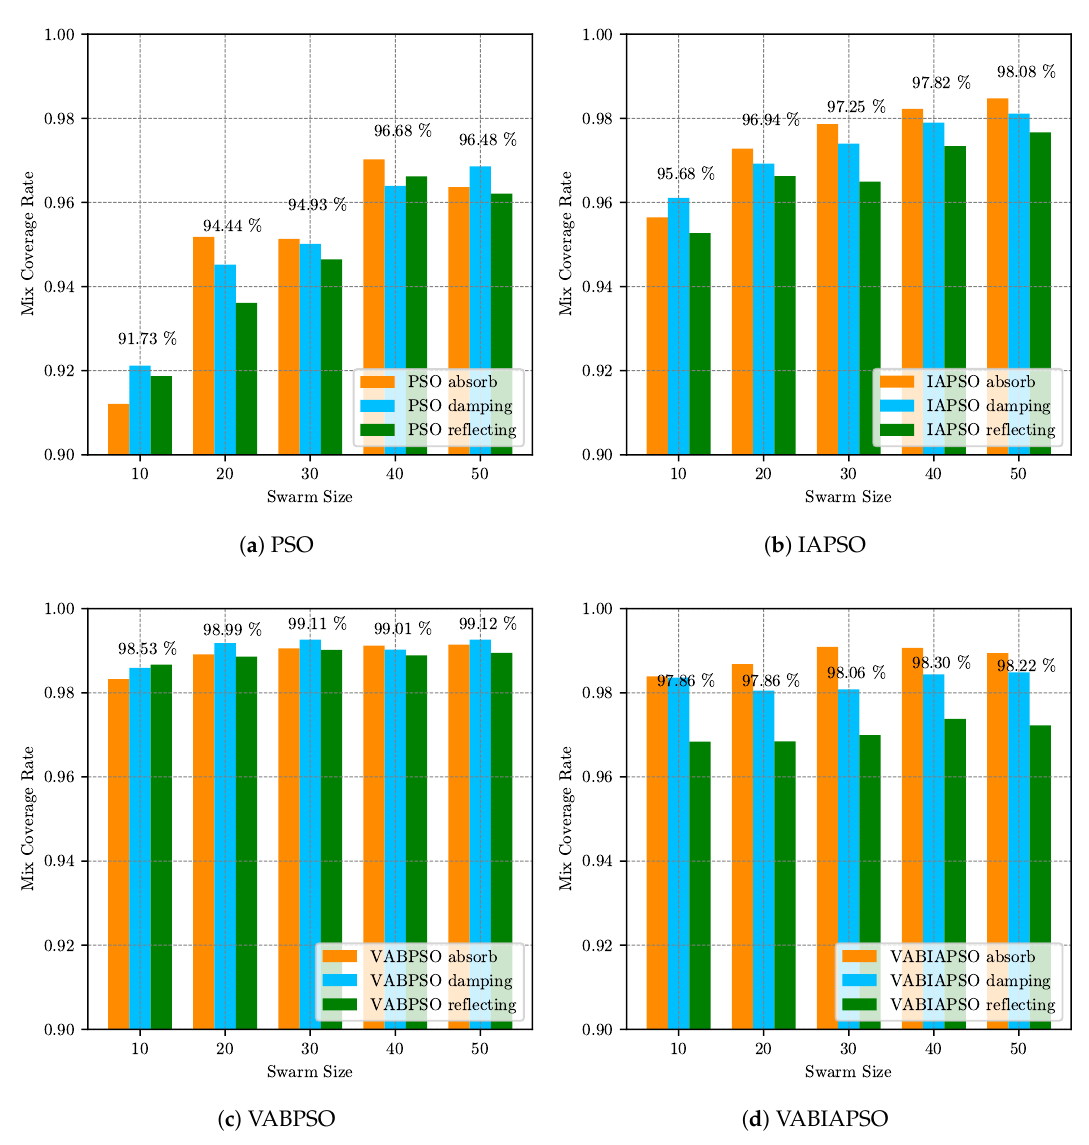
Figure 5. The mix coverage of the four algorithms under different swarm sizes in the ideal